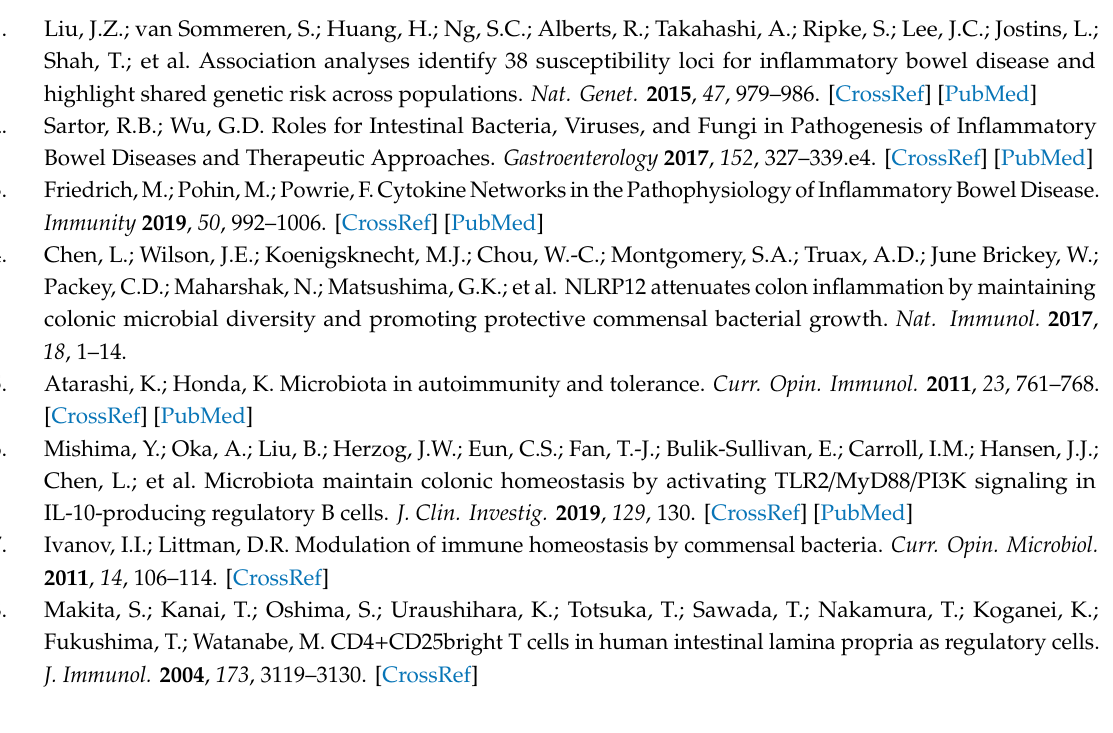
Figure S1: B cell population is significantly reduced in PI3K δ D910A mice, Figure S2: The inflammatory or regulatory phenotypes of MLN and spleen cells are determined by PI3K δ signaling, Figure S3: The median fluorescence intensities of GFP in T cells and B cells, Figure S4: Phenotypic characteristics of B cells in PI3K δ D910A mice, Figure S5: Blockade of IL-10 signaling increases IL-12p40 secretion by B cells, Table S1: Antibodies used in the present